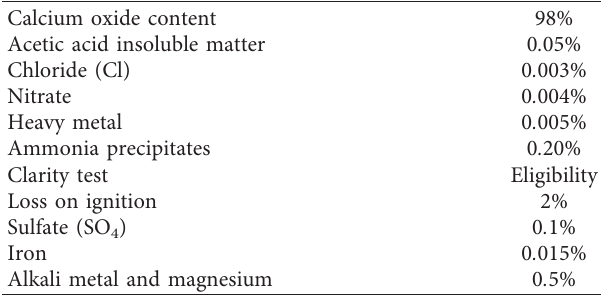
Table 4: Technical conditions of quicklime.